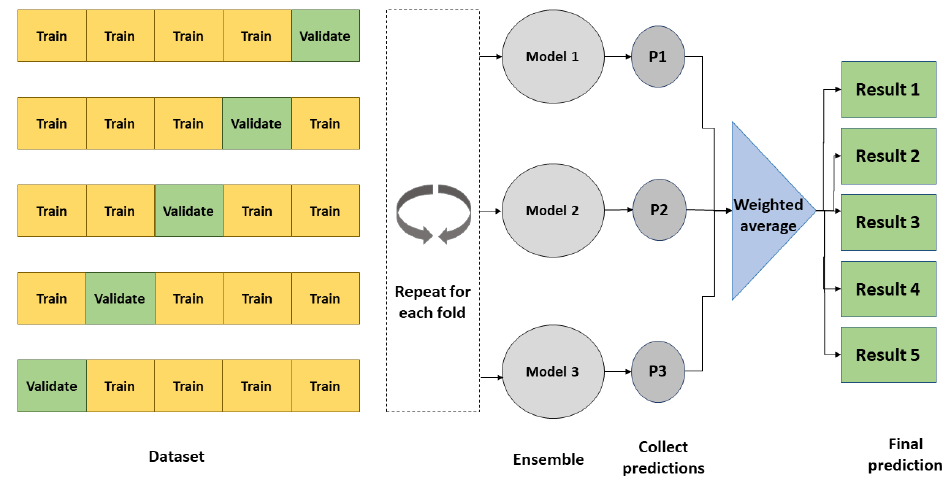
Figure 4. 5-Folds